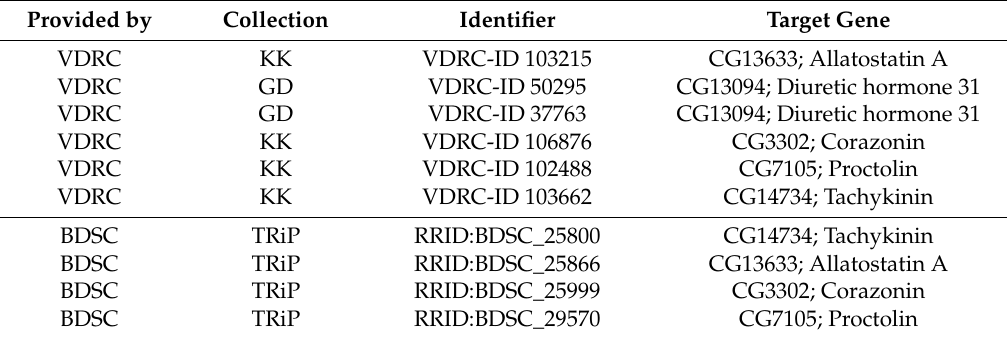
Table 2. RNAi lines used in this